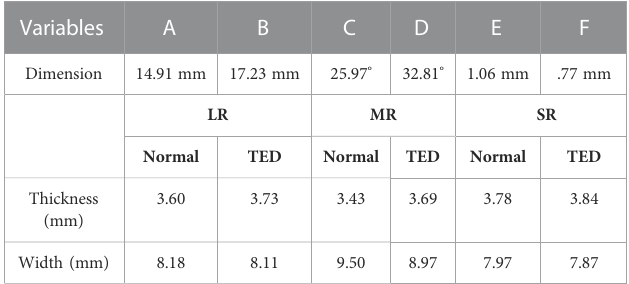
TABLE 1 Dimensions measured in Figure 1.